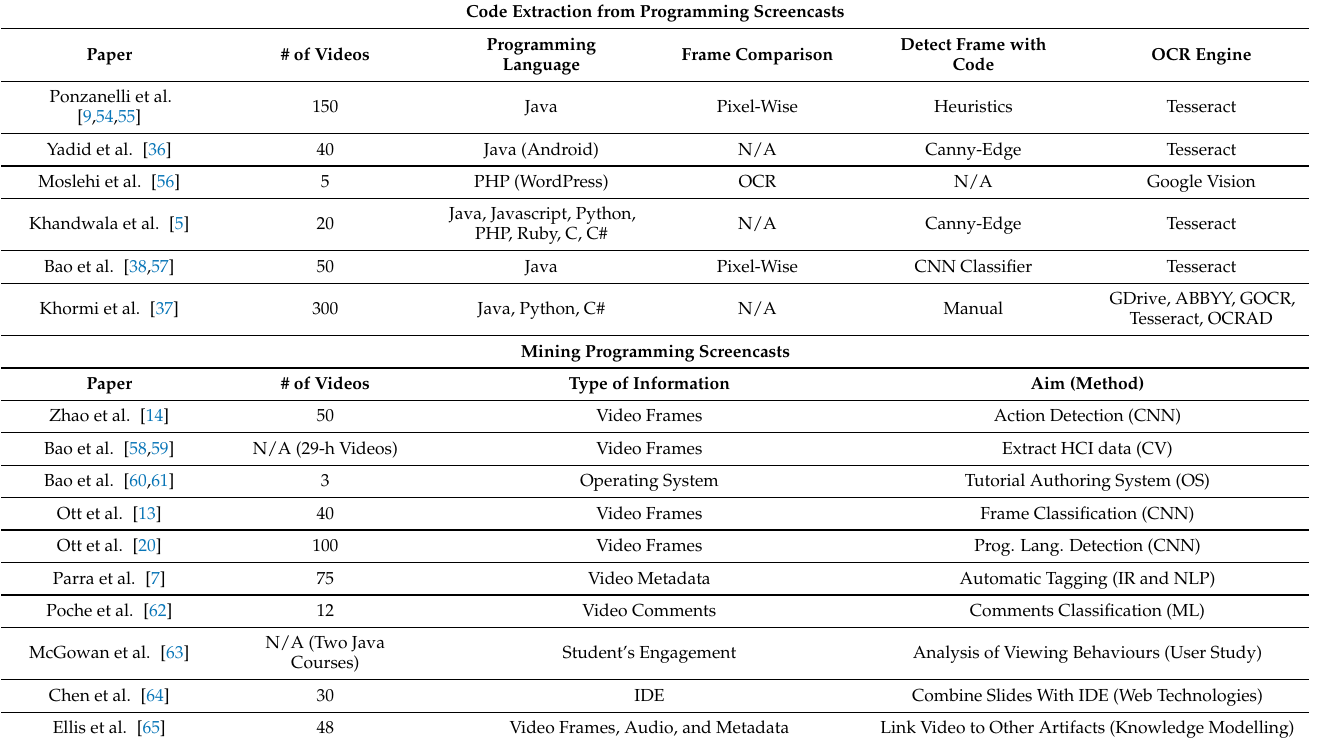
Table 7. This table surveys the related work on code extraction, mining programming screencasts, and the works that applied transfer learning in classifying/localizing image